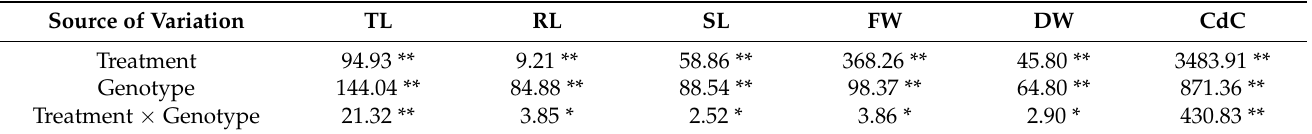
Table 2. ANOVA of F values for growth traits and Cd uptake between lentil genotypes, Cd treatments, and their interaction. Source of